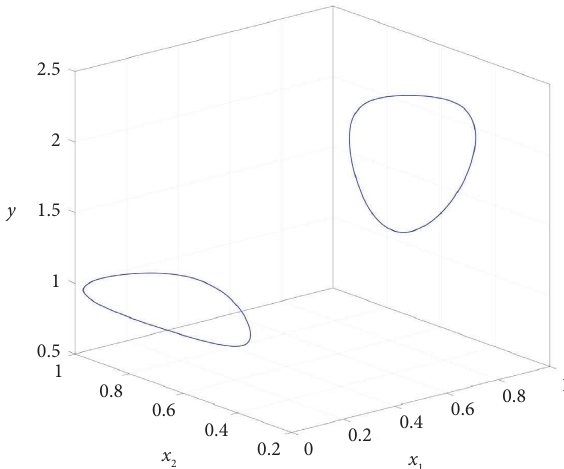
, μ ,p, F,c, a ) � ( 1 , 0 . 1 , 0 . 8 , 5 , 0 . 5 , 3 ) . (b) Chaotic oscillations. Parameter values as in (a), but a � 10. 1 2